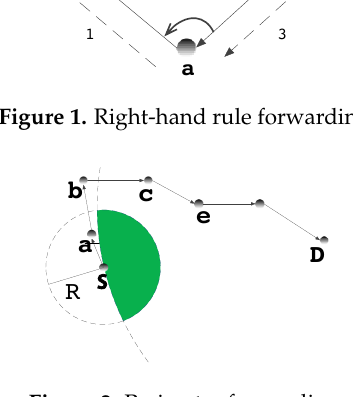
Figure 2. Perimeter